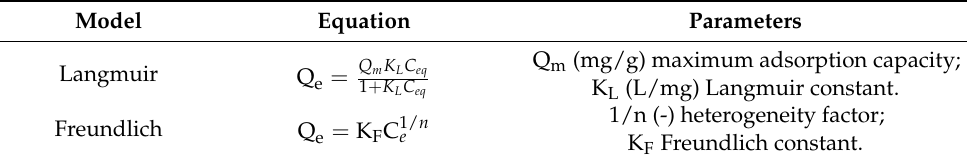
Table 1. Equations of the isotherm models used in this